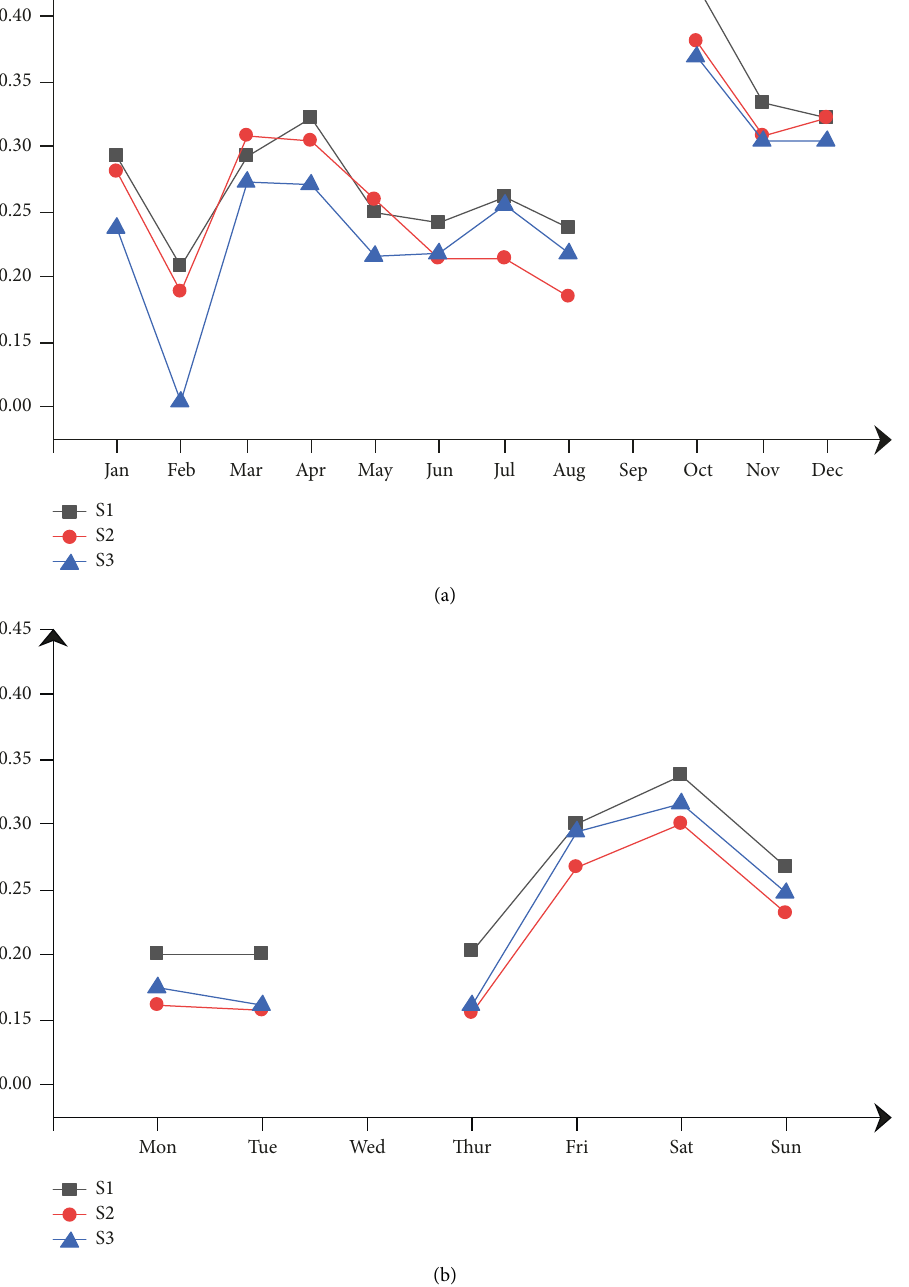
Figure 6: Variation of the regression coefficients in months (a) and days